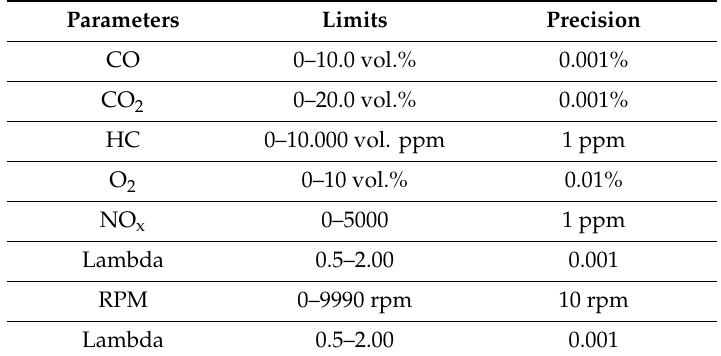
Table 5. Measurement ranges of the exhaust gas analyzer.